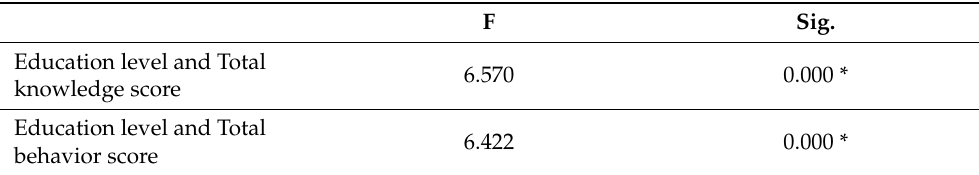
Table 6. Education level and total knowledge score/total behavioral score